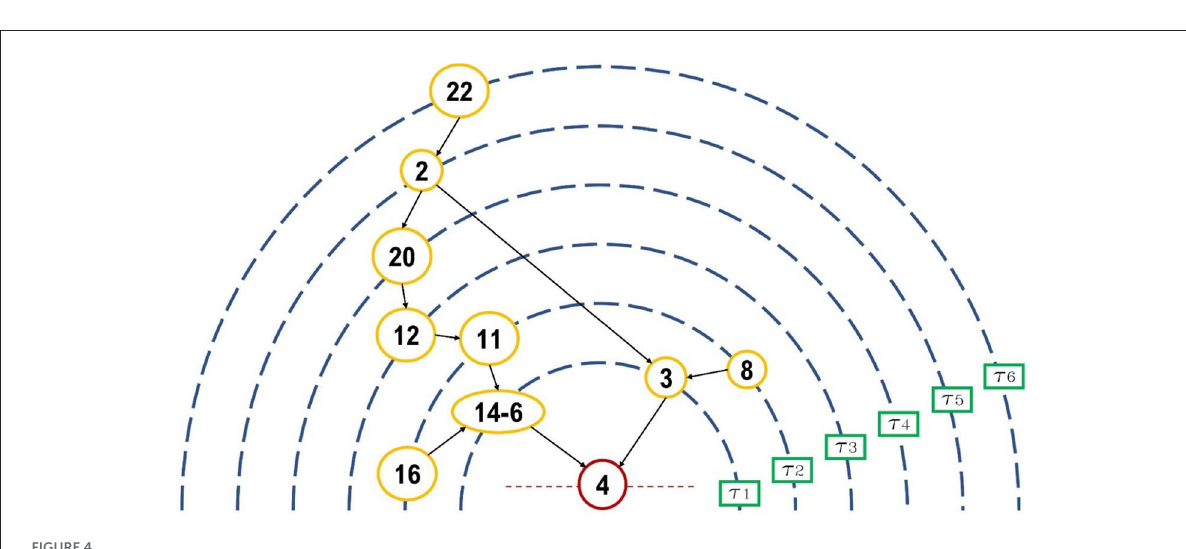
FIGURE4 Disassembly wave logical